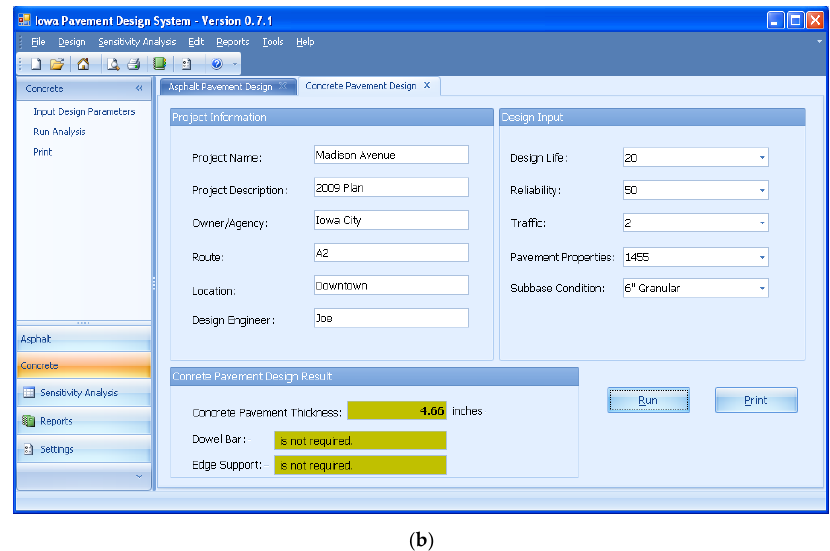
Figure 7. User interface for asphalt and concrete pavement thickness design modules. ( a ) Asphalt pavement thickness design module. ( b ) Concrete pavement thickness design module.